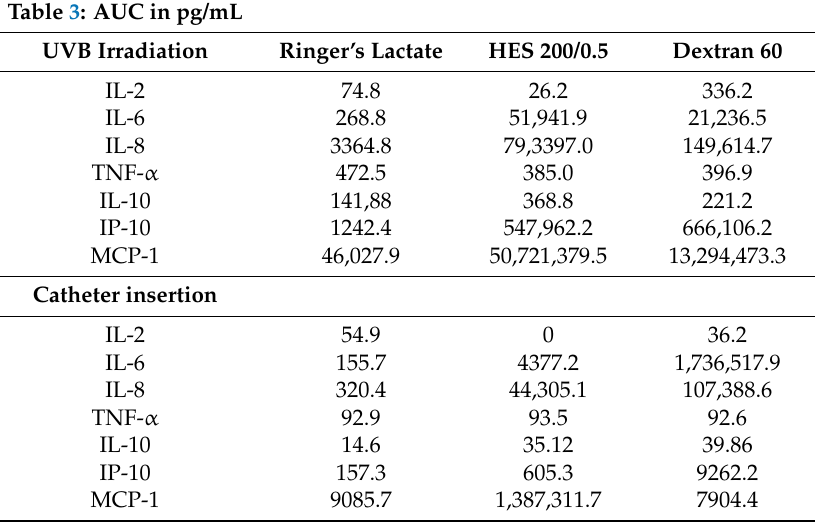
Table 3. Cytokine concentrations plotted as the area under the curve (pg/mL/m 2 ) for insertion and UVB irradiation. Table 3: AUC in pg/mL UVB